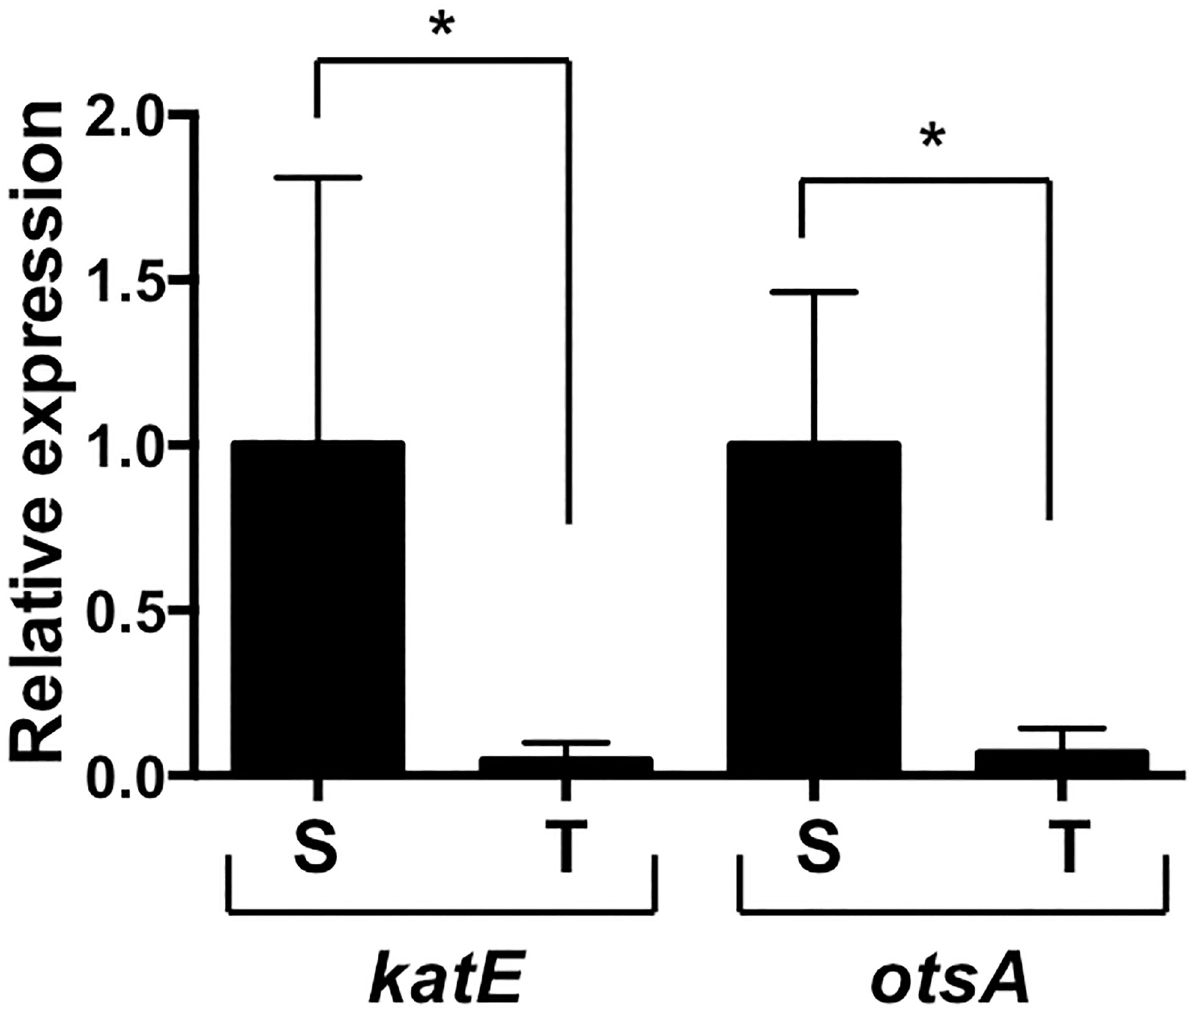
Fig 4. Expression of rpoS target genes in SL1344 and Ty2. Expression of the katE and otsA genes in overnight shaking cultures of SL1344 (S) and Ty2 (T) was determined by quantitative reverse transcription-PCR. Levels of each transcript were calculated relative to the levels in SL1344. � p = 0.02, n = 4 or 5 per